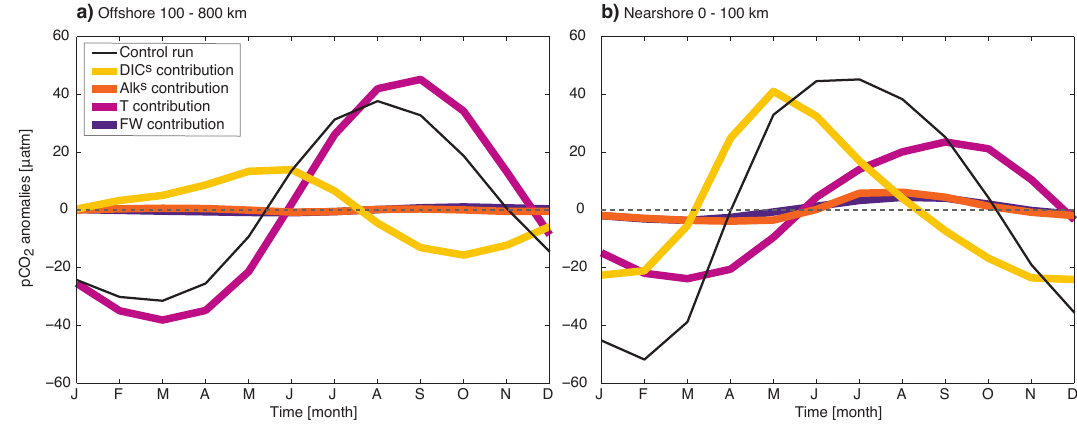
Fig. 9. Monthly mean p CO 2 anomalies for the offshore (a) and the nearshore (b) domains: the colored lines represent the contributions of the four drivers DIC s , Alk s , T and FW to monthly mean p CO 2 anomalies from the control simulation (black line).